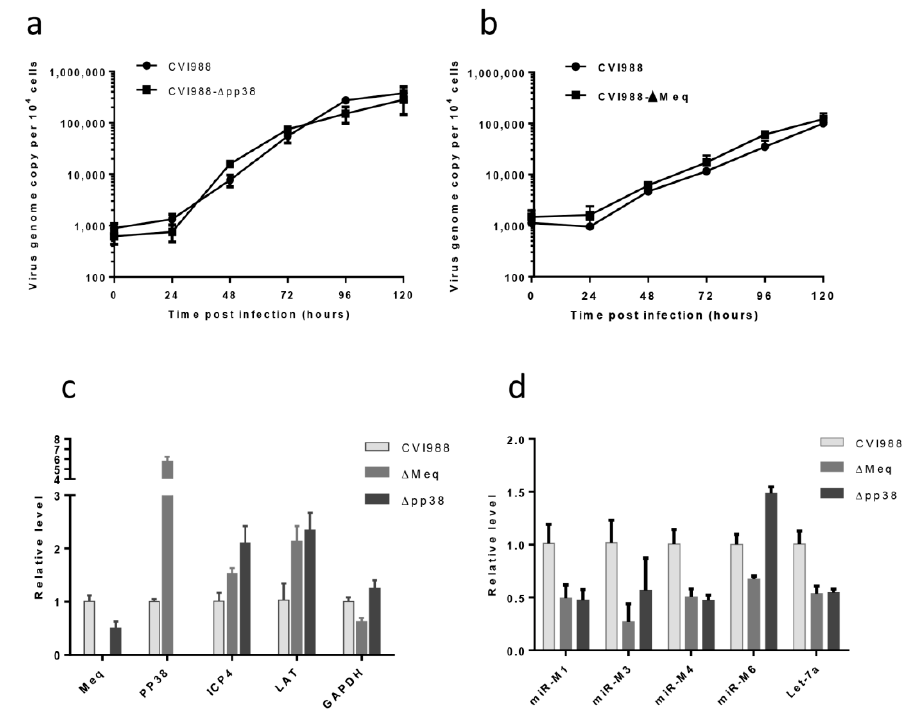
Figure 4. Characterization of mutant viruses. In vitro growth rates of CVI988- Δ pp38 ( a ) and CVI988- Δ Meq ( b ) along with the parental CVI988 measured from the viral genome copy numbers, determined using TaqMan real-time qPCR on DNA extracted from CEF, harvested at various time points after inoculation. Viral genome copy numbers per 10,000 cells (shown with 95% confidence intervals) are shown on the y axis. There was no difference in the replication of parental CVI988 and the mutant viruses. ( c ) Relative expression of MDV genes Meq , pp38 , ICP4 , LAT and host gene GAPDH measured by qRT-PCR (normalized to MDV gene gB ) in RNA extracted from CEF infected with the parental CVI988 and the different mutant viruses. Results represent the mean of triplicate assays with error bars showing the standard errors of the mean. ( d ) Relative expression of MDV-1 miRNAs miR-M1, miR-M3, miR-M4, miR-M6 and host miRNA let-7a measured by qRT-PCR (normalized to MDV1-miR-M7) in RNA extracted from CEF infected with the parental CVI988 and the different mutant viruses. Results represent the mean of triplicate assays with error bars showing the standard errors of the mean.